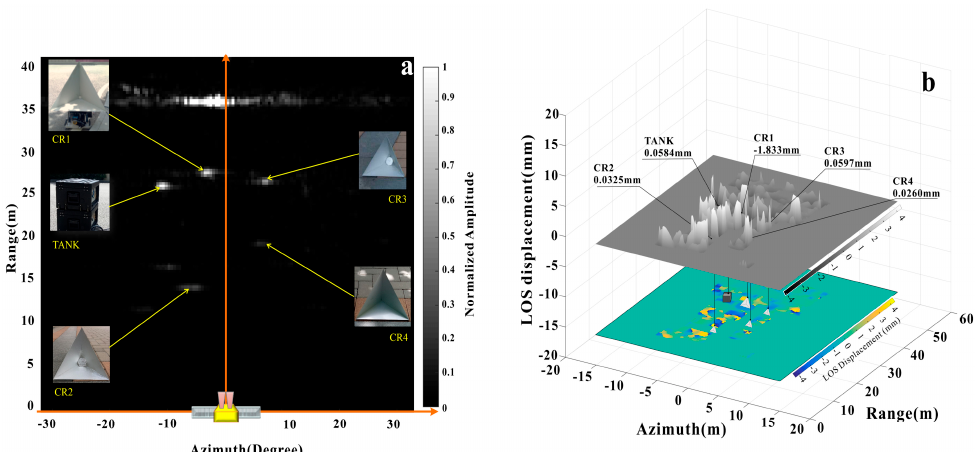
Figure 9. Typical SAR images ( a ) Amplitude image in polar coordinates; the “bright spots” are the corresponding targets; ( b ) The upper shows “surf plot”, displacements that were varied both in height and grayscale, the lower is the displacement map plotted as a color map.